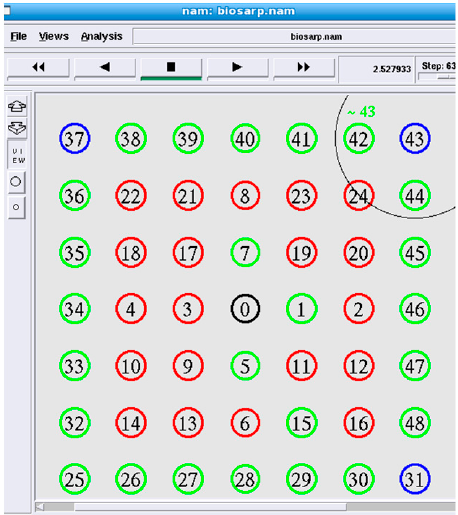
Figure 7. Worst-case scenario with 20 malicious nodes, as indicated in red.